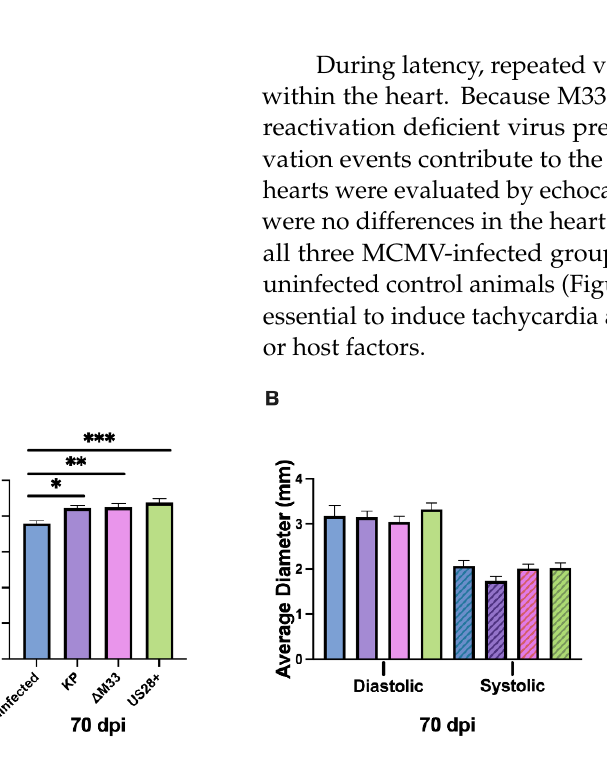
Figure 4. MCMV-induced calcification during latent infection. Animals were uninfected or infected with 1 × 10 6 PFU by i.p. inoculation. At 70 dpi, ( A ) hearts were stained with Alizarin red solution to evaluate calcification in duplicate ( n = 4). ( B ) Hearts were scored on the basis of the estimated pa- thology on the outer epicardium, as previously described. Studies were conducted in triplicate ( n = 15).